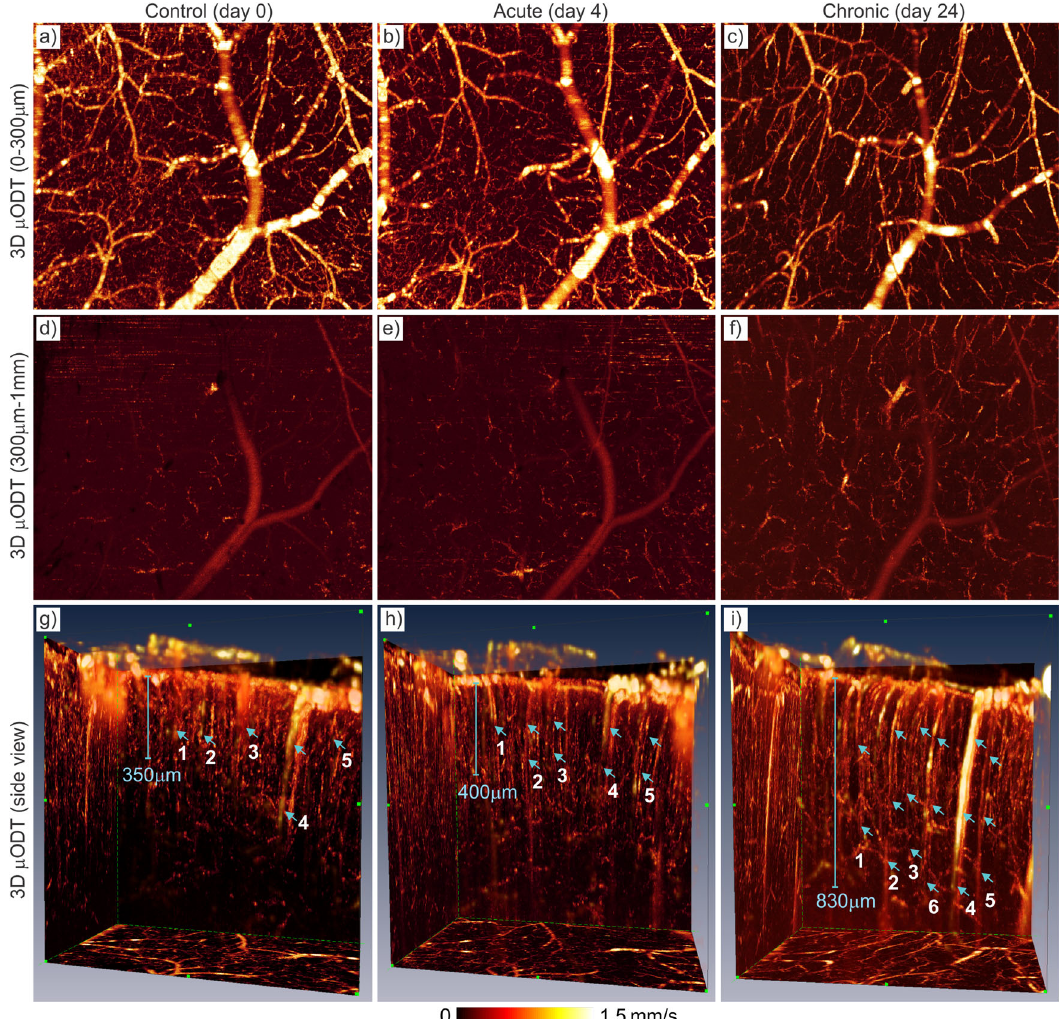
Fig. 9 Chronic cocaine-induced redistribution of the CBFv networks in the cortex imaged in an awake mouse. a – c 3D μ ODT images (2.3 × 2 × 0.3 mm 3 ) in upper cortex (e.g., L1-L3) on day 0 (control), day 4 (acute cocaine), and day 24 (chronic cocaine), showing reduced capillary CBFv beds and extended AF and VF branches in chronic case ( c ); d – f the corresponding 3D μ ODT images (2.3 × 2 × 0.7 mm 3 ) in deeper cortex (e.g., L3-L6 and below), showing increased CBFv in AF and VF branches and capillary beds in chronic case ( f ); g – i side view of μ ODT images to illustrate diving arteriolar fl ows and ascending venular fl ows extending deeper into lower cortical layers due to capillary fl ow redistribution resulting from chronic cocaine exposure. Light blue arrows highlight extended depths of the selected six diving arteriolar and ascending venular fl ows ( i = 1, … , 6). Total accumulated cocaine doses: 3 mg/kg for acute and accumulated doses of 13 mg/kg for chronic